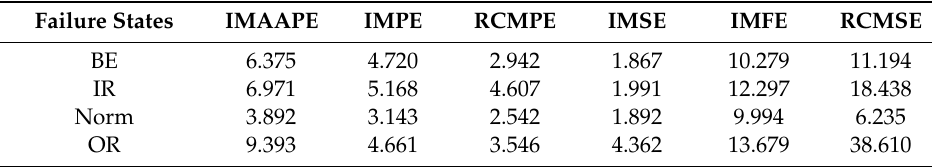
Table 5. The ratio of the between-class distance to the within-class distance.